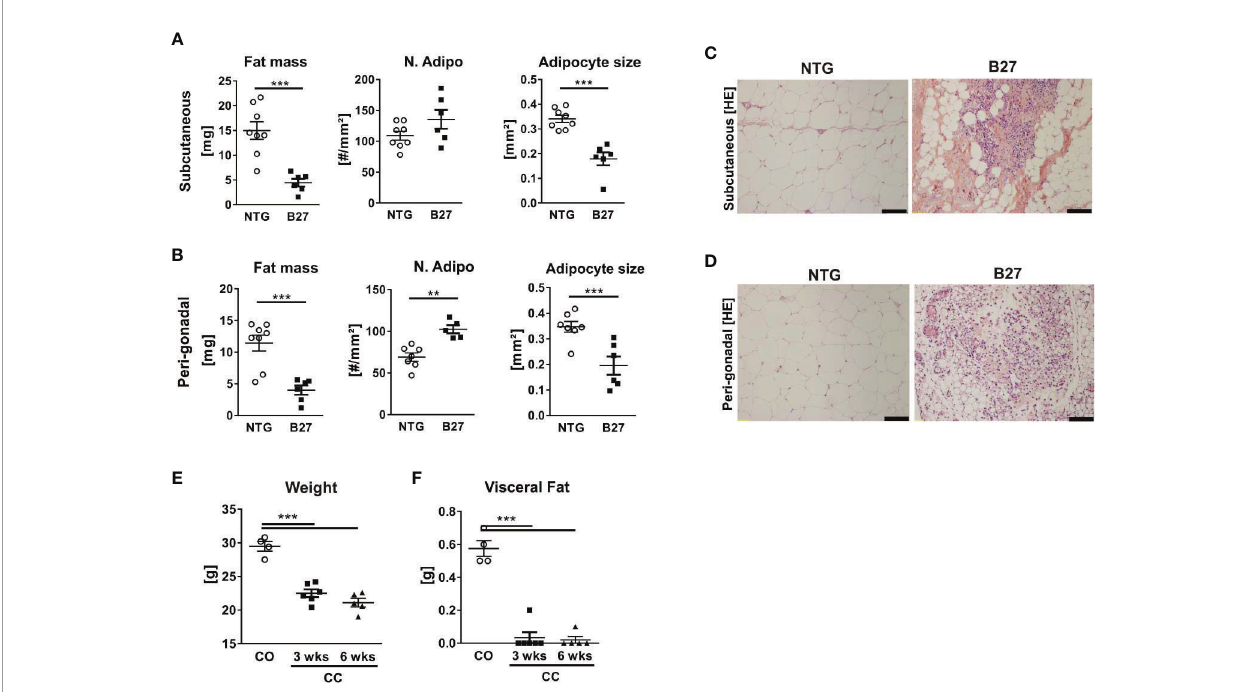
FIGURE 3 | Chronic in fl ammation in rodent models of SpA leads to loss of white adipose tissue. (A, B) Fat mass, number, and size of adipocytes in subcutaneous (top) and peri-gonadal (bottom) adipose tissue of NTG and B27 rats. (C, D) Representative histology sections stained with hematoxylin/eosin staining. Scale bars: 100 m m (n=6-8 per group). (E, F) Bodyweight and visceral fat weight of SKG mice at 3- and 6-weeks post-curdlan challenge vs. control group (n=4-6 per group). Results are presented as individual dots with the mean indicated as horizontal line. **p ≤ 0.01, and ***p ≤ 0.001 vs controls via unpaired Student´s t-test (A, B) and one-way ANOVA with Tukey ’ s post hoc test (E, F) .